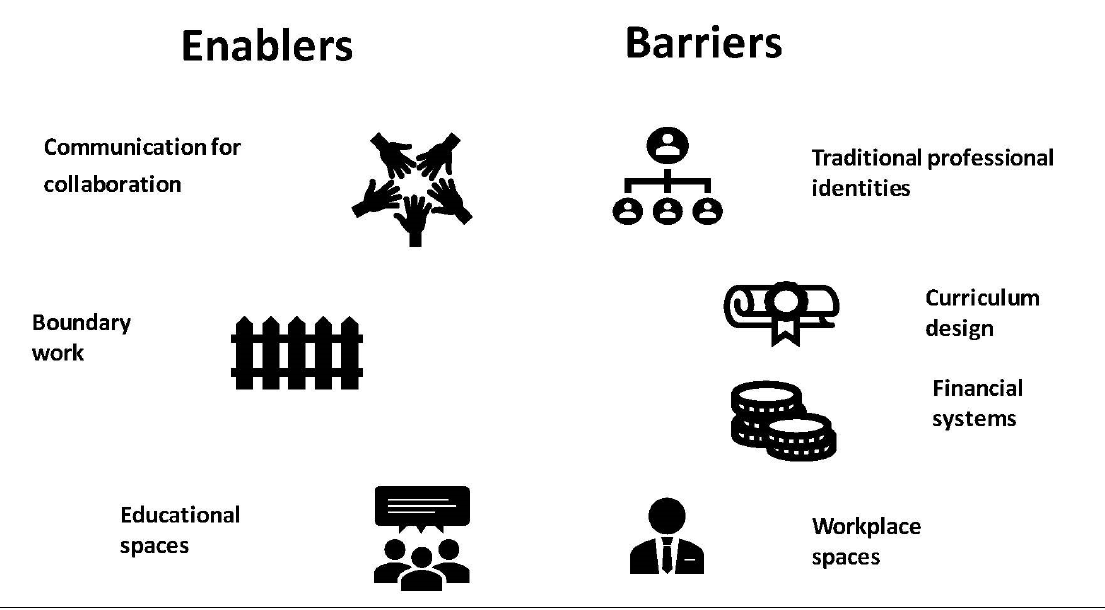
Figure 1. Enablers and barriers to collaboration (Source: